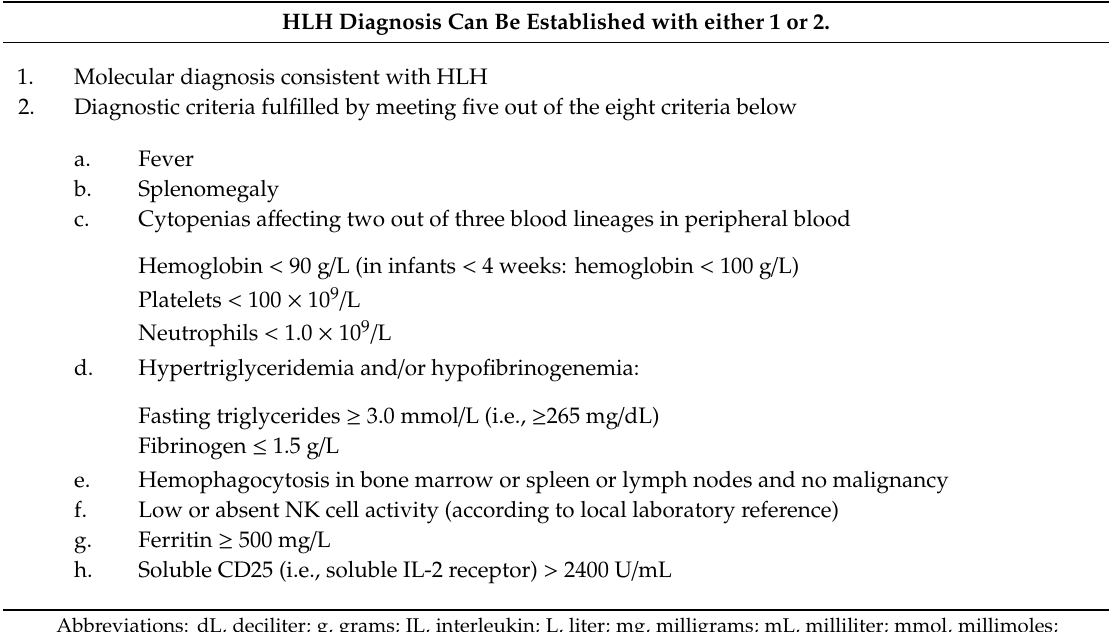
Table 2. 2004 diagnostic criteria for hemophagocytic lymphohistiocytosis (HLH) [36]. HLH Diagnosis Can Be Established with either 1 or